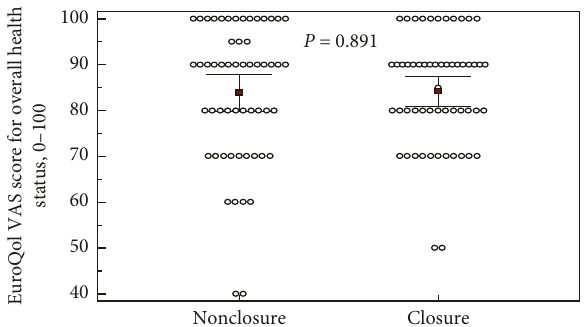
Figure 4: EuroQol-5D-5L VAS scores for overall health status assessment. EuroQol-5D-5L VAS scores for overall health status assessment by the patient at postoperative day 10 are also shown. The greater value indicates better health status. Each group includes 56 patients. Square plots show mean values (83.84 vs. 84.2) and horizontal lines show confidence intervals (79.9–87.8 vs. 81–87.4) at 95% level. p value calculated using a Student’s t